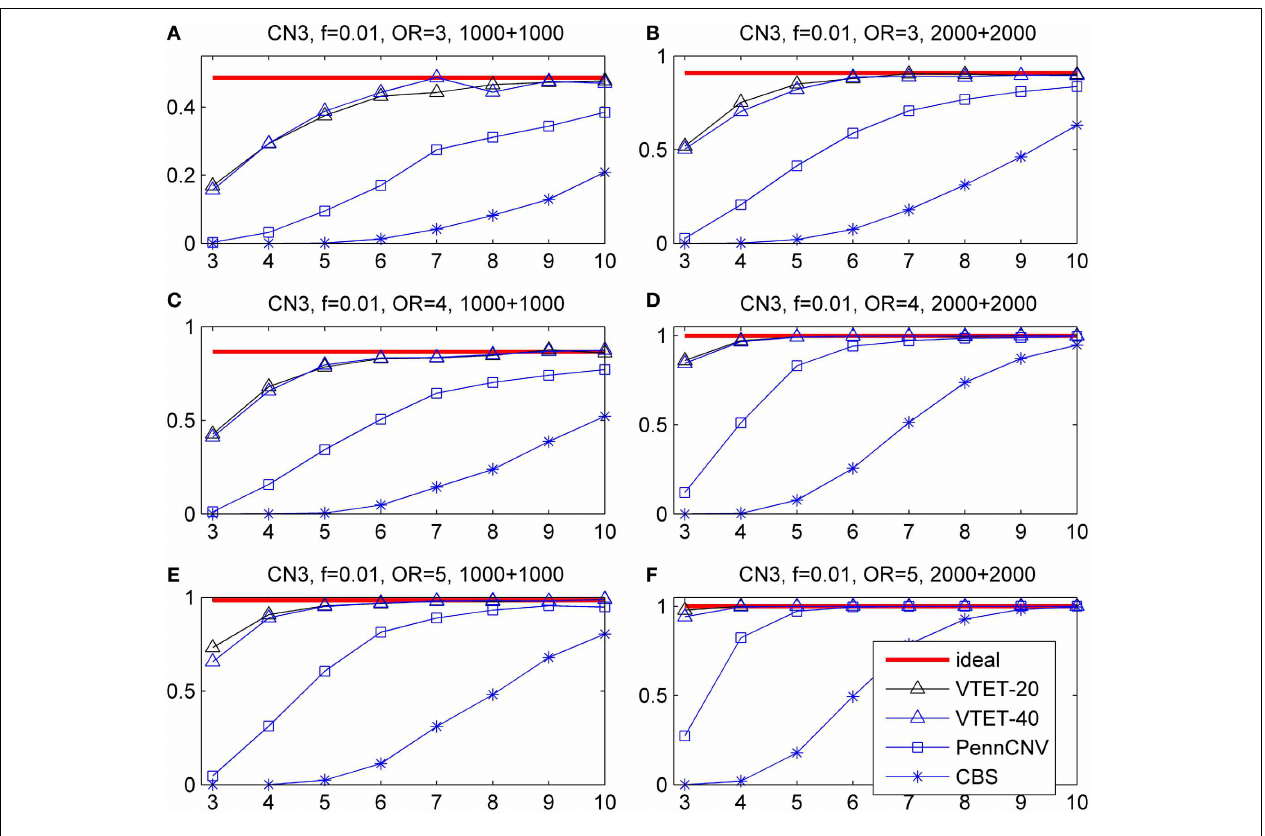
FIGURE 4 | Statistical power for detecting the association of duplications with three copies (CN3) with locations randomly distributed in a given region. f is the frequency of CNVs in the general population. OR is odds ratio. Powers were calculated based on